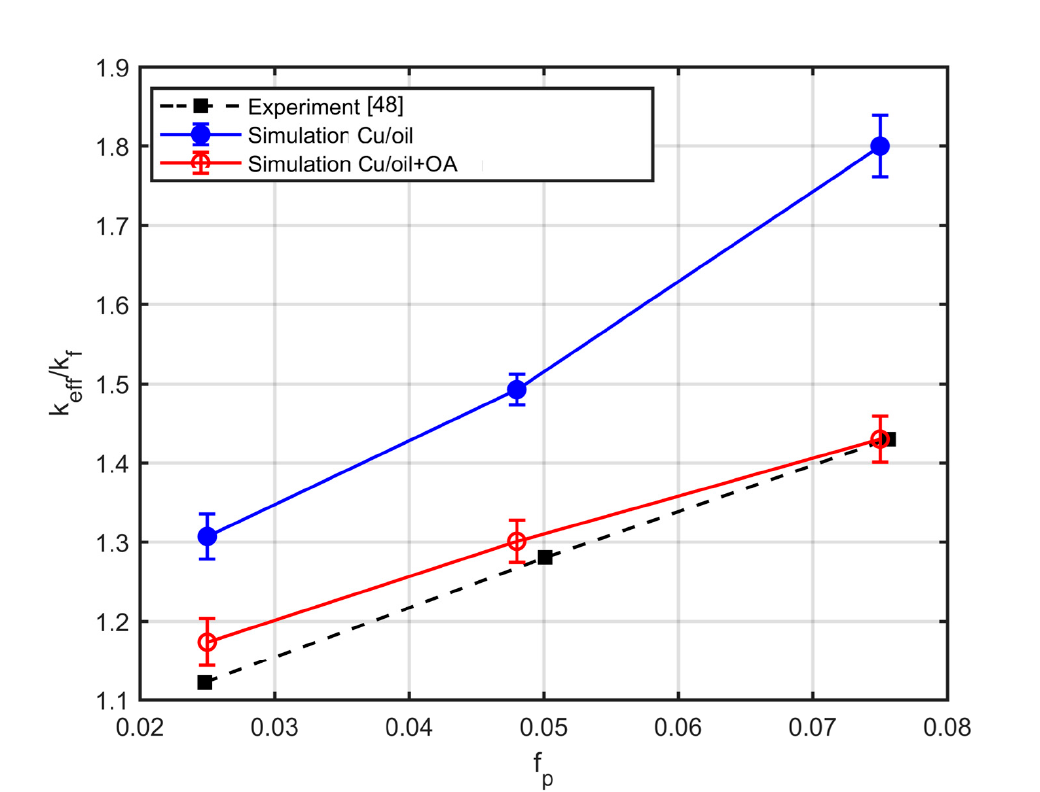
Figure 17. Comparison of experimental results [48] (black squares) and simulation results, without the surfactant (blue dots) and with the surfactant (red